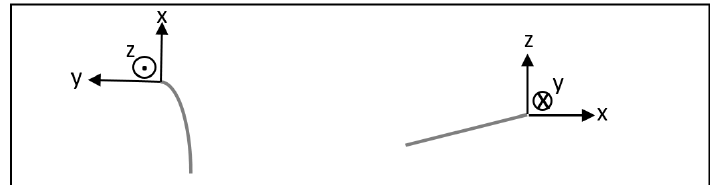
Figure 8. The coordinate system at the anterior end of the cantilever with the directions of the positive x-, y-, and z-axes. ( Left ) occlusal view. ( Right ) sagittal view.